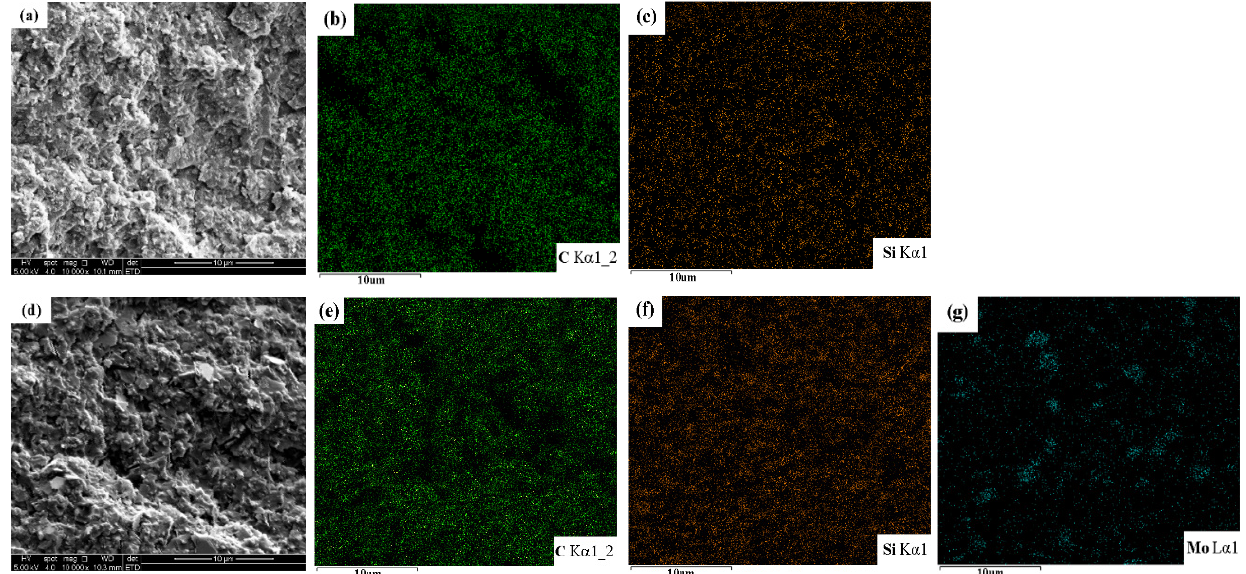
Figure 4. Fracture morphology of S0 ( a ) and EDS results of C ( b ); Si ( c ), and Fracture morphology of S5 ( d ) and EDS results of C ( e ); Si ( f ); Mo ( g ).